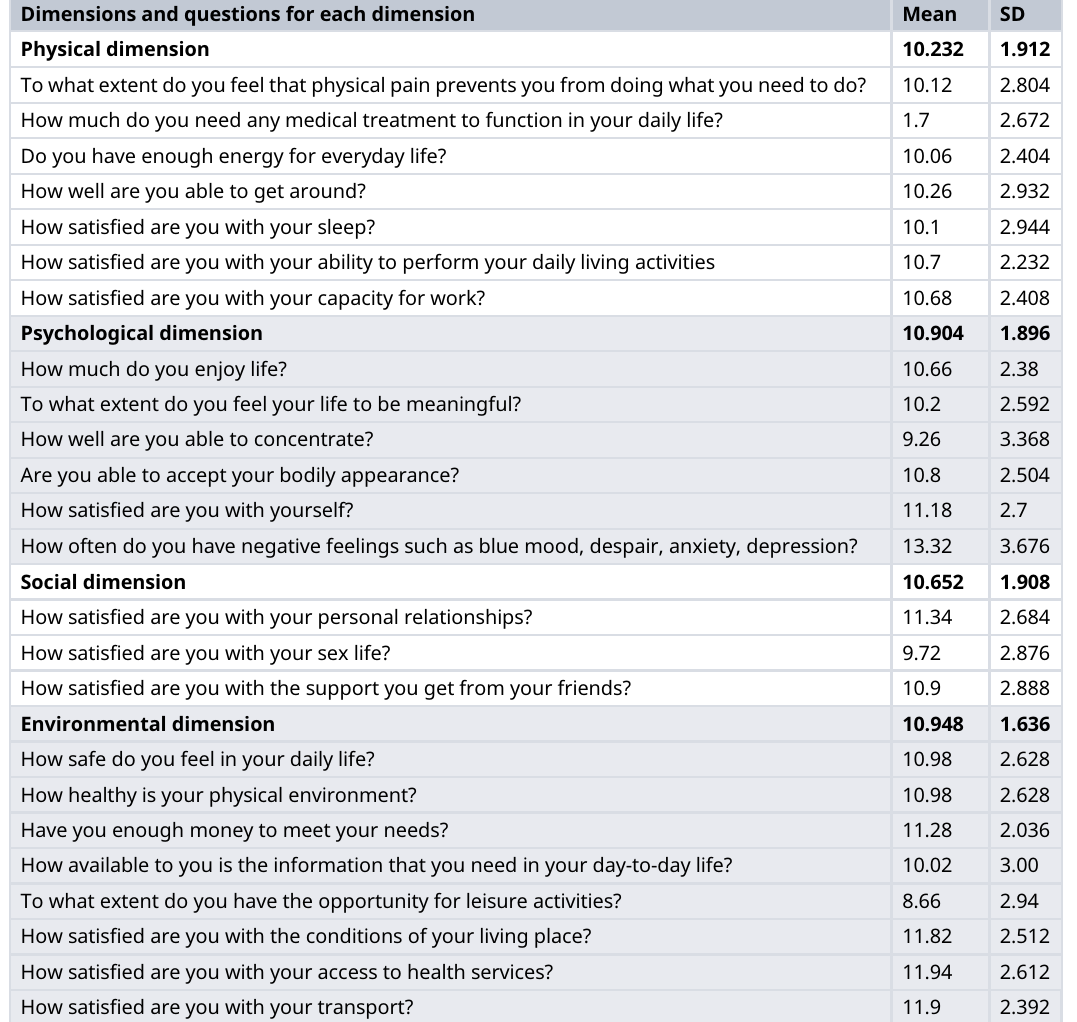
Table 2. Analysis of the WHOQoL-BREF items and dimensions. Dimensions and questions for each dimension